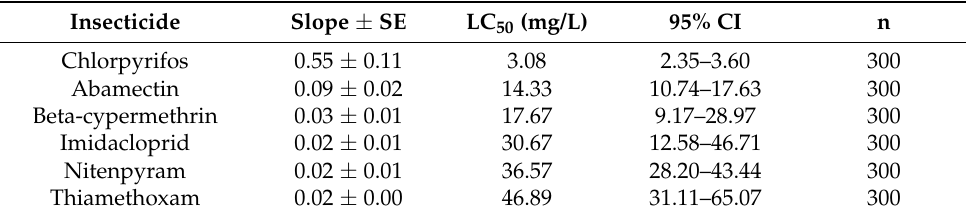
Table 3. Susceptibility of Uroleucon formosanum to six